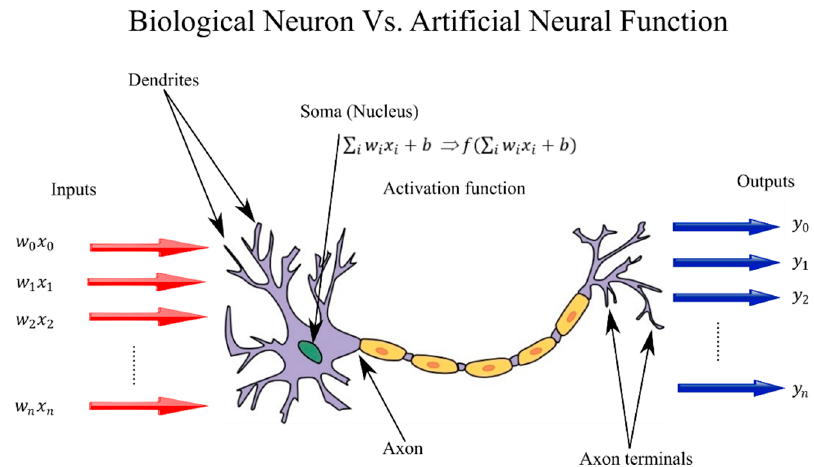
Figure 1. A single biological neuron is annotated to describe a single artificial neural function.